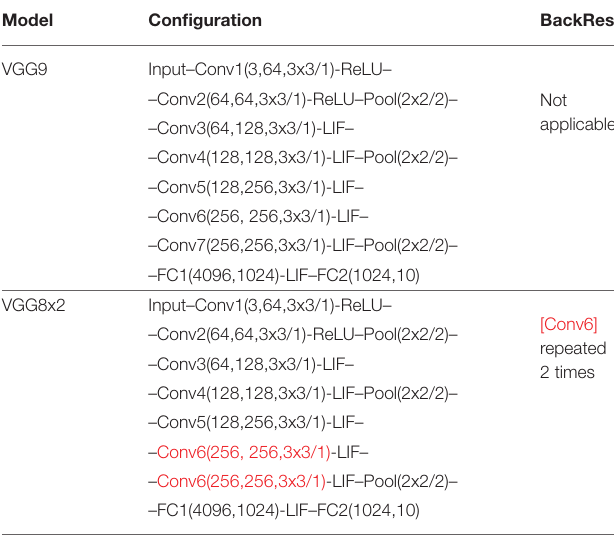
TABLE 15 | Network topologies for AGD training methodology with hybrid layers and stochmax classifier at the